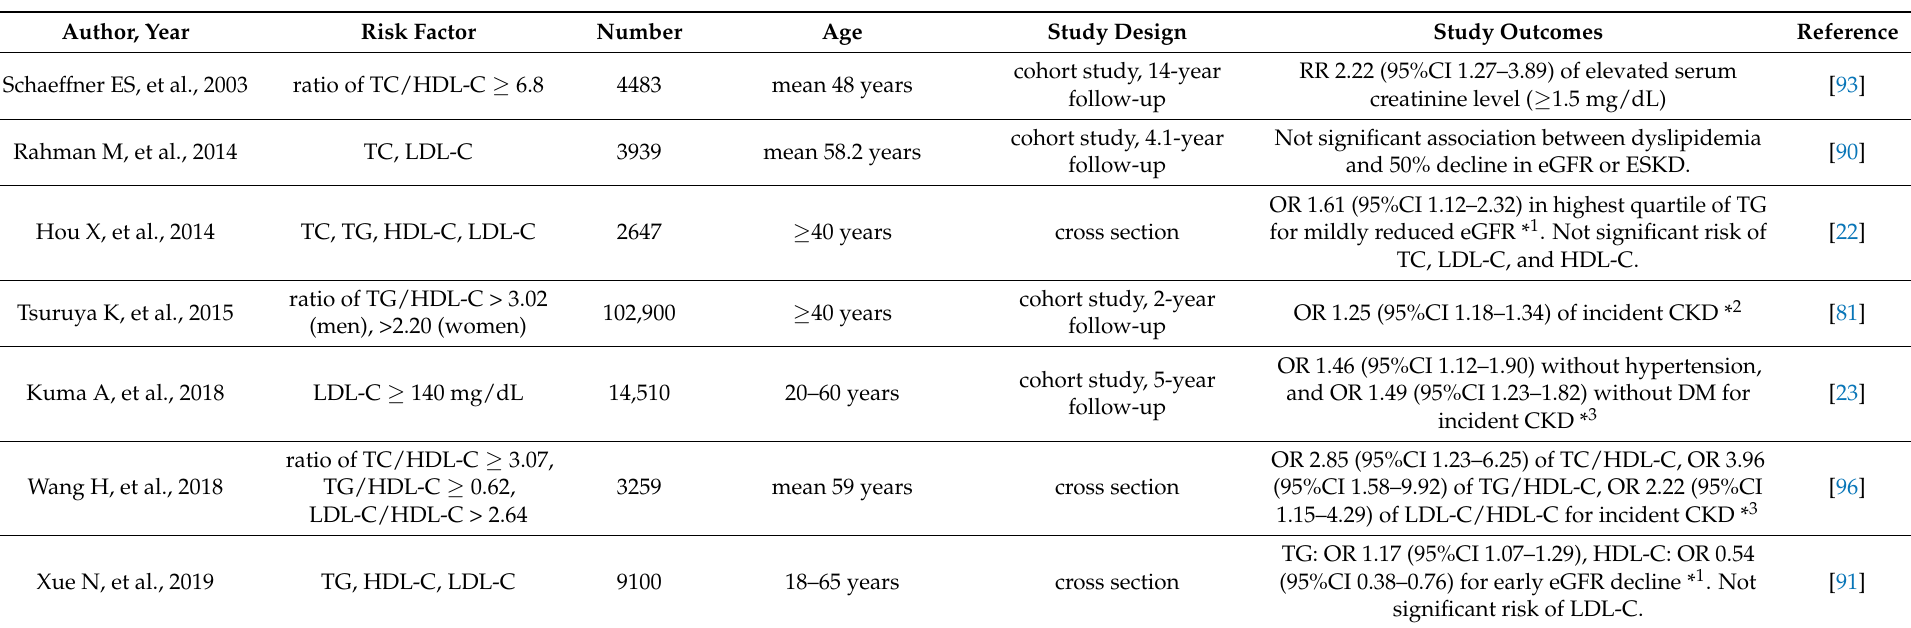
Table 2. Outcomes of previous studies focused on risk of dyslipidemia for chronic kidney disease in young- and middle-aged